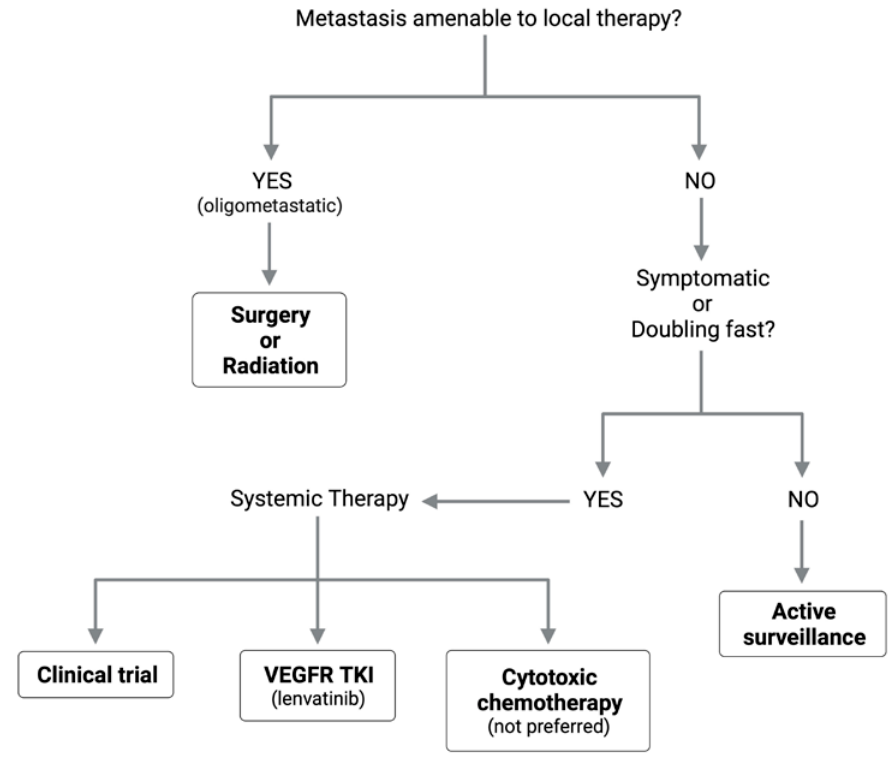
Figure 3. Framework for treatment modality selection based on metastatic lesion characteristics.